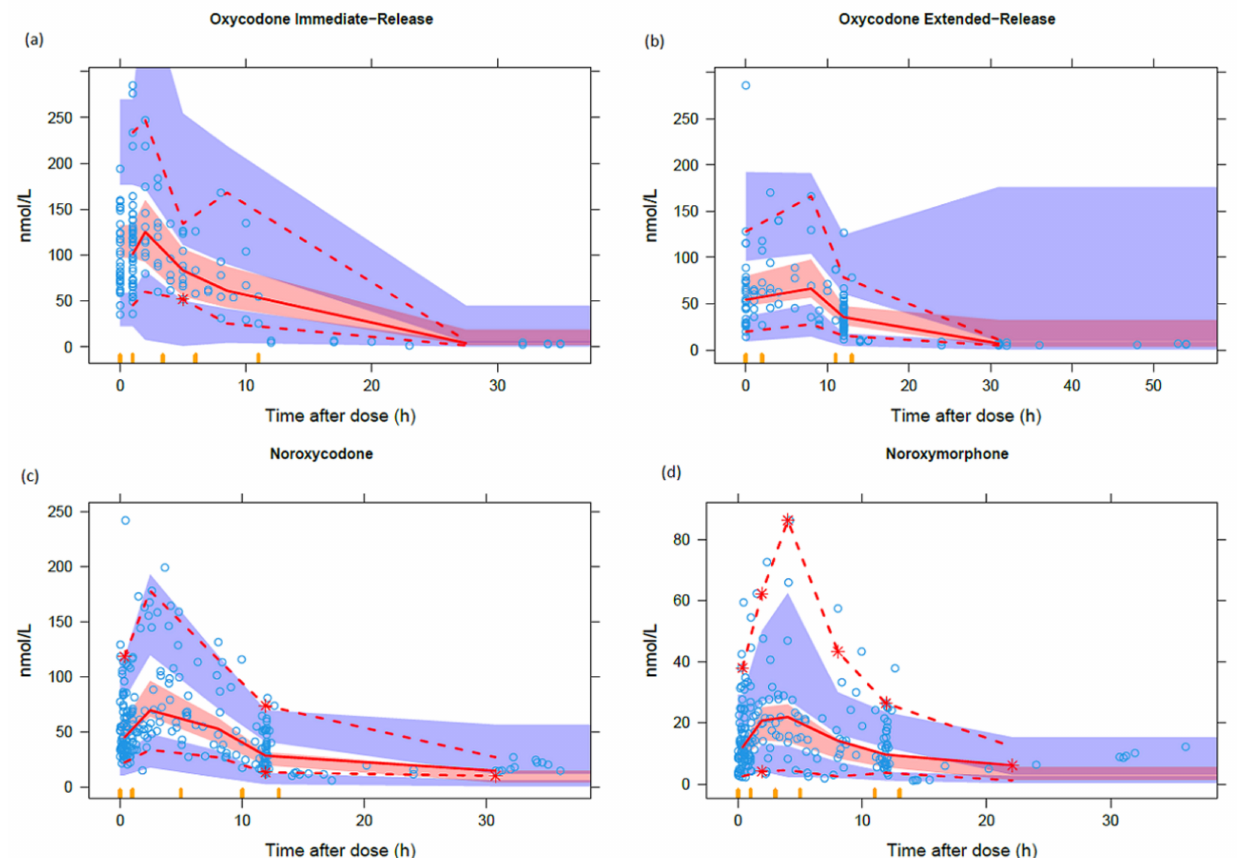
Figure 3. Prediction-corrected visual predictive checks of the final pharmacokinetic model of ( a ) oxycodone immediate- release, ( b ) oxycodone extended-release, ( c ) nor-oxycodone and ( d ) nor-oxymorphone ( n = 1000). The solid red lines represent the median of the observed values. The dashed lines represent the 5 and 95% percentiles of the observed values. The red shaded areas represent the model-predicted median (with 95% confidence intervals for the prediction). The blue shaded areas represent the model-predicted 5 and 95% percentiles (both with 95% confidence intervals for the